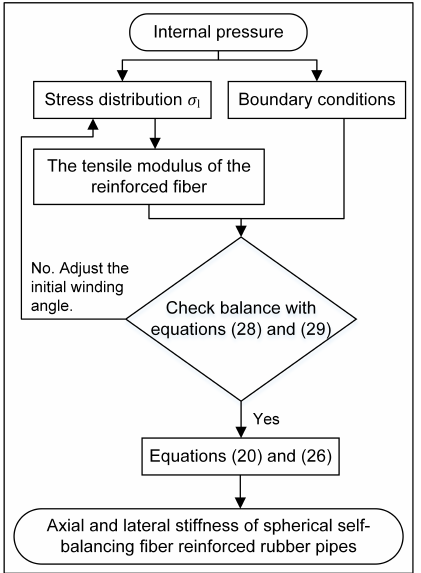
Figure 10: The approach of stiffness calculation of self-balancing fiber reinforced rubber pipes.